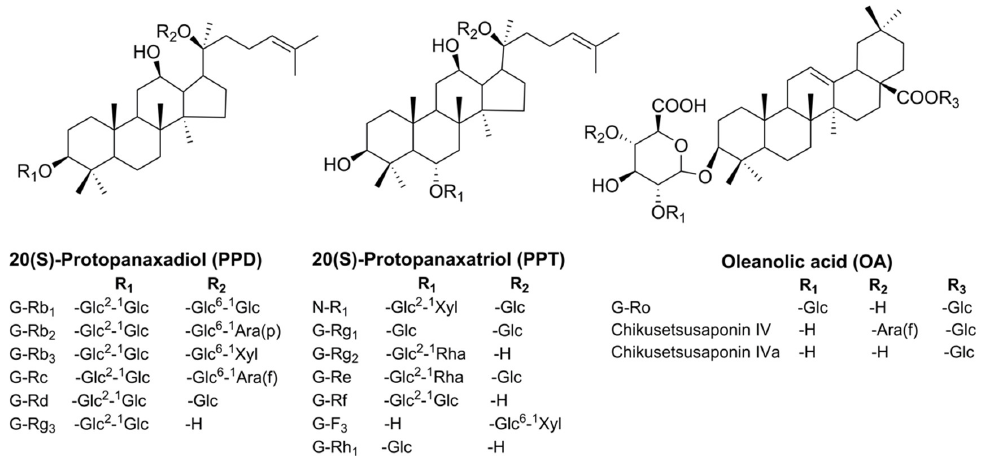
Figure 1. The chemical structures of the 16 reference standards.